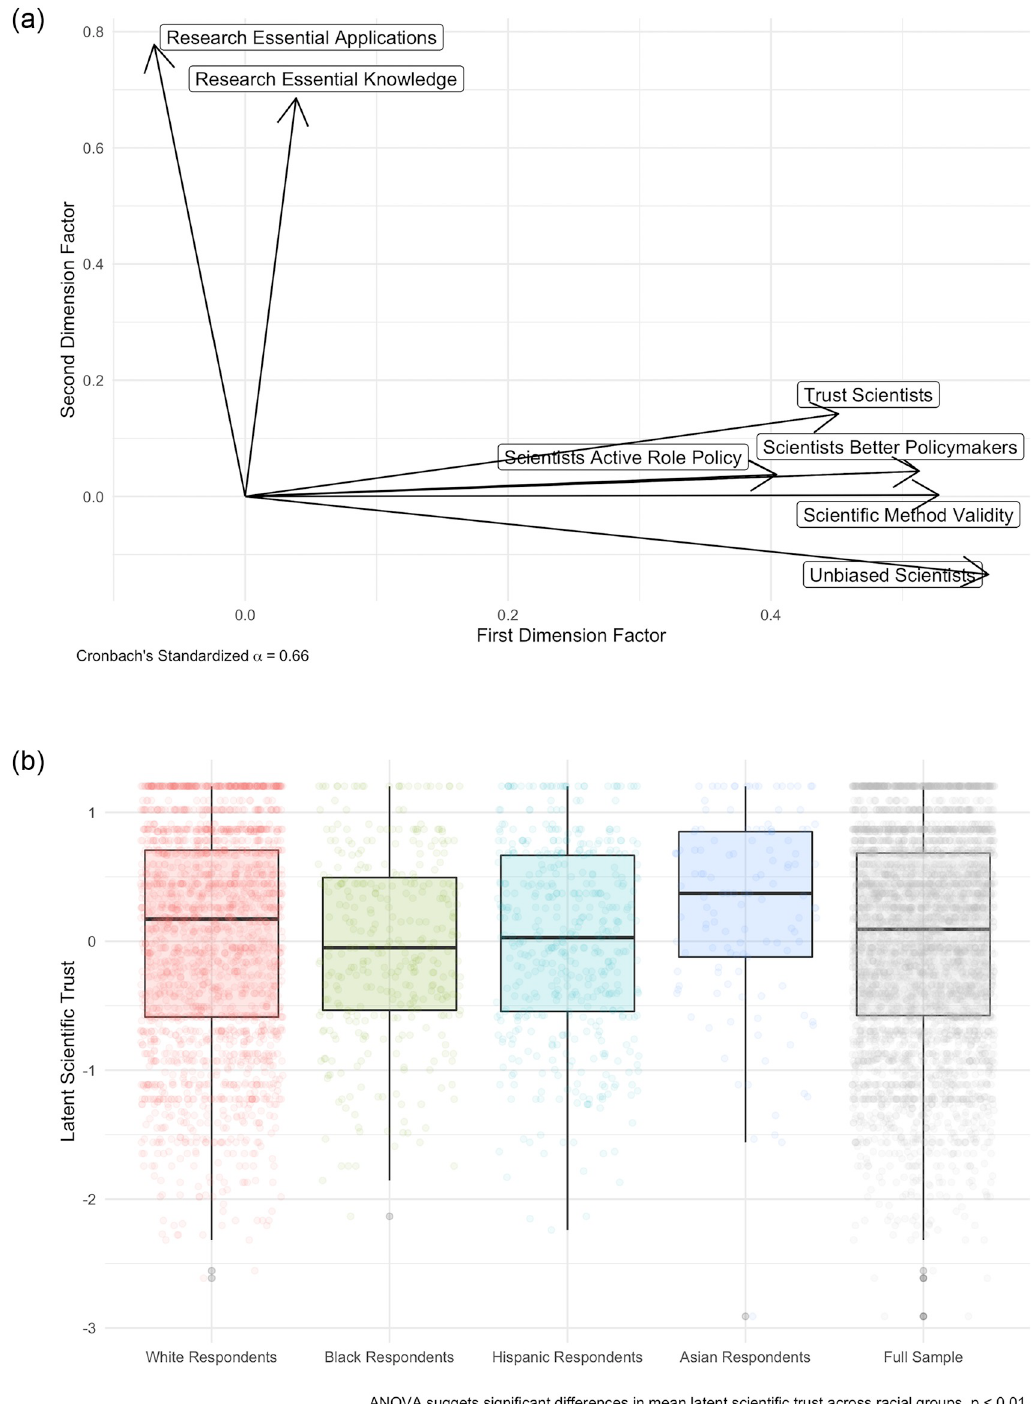
Fig 1. Measuring latent scientific trust in the mass public. A: Latent scientific trust as measured by factor analysis. B: Distribution of latent scientific trust by race.